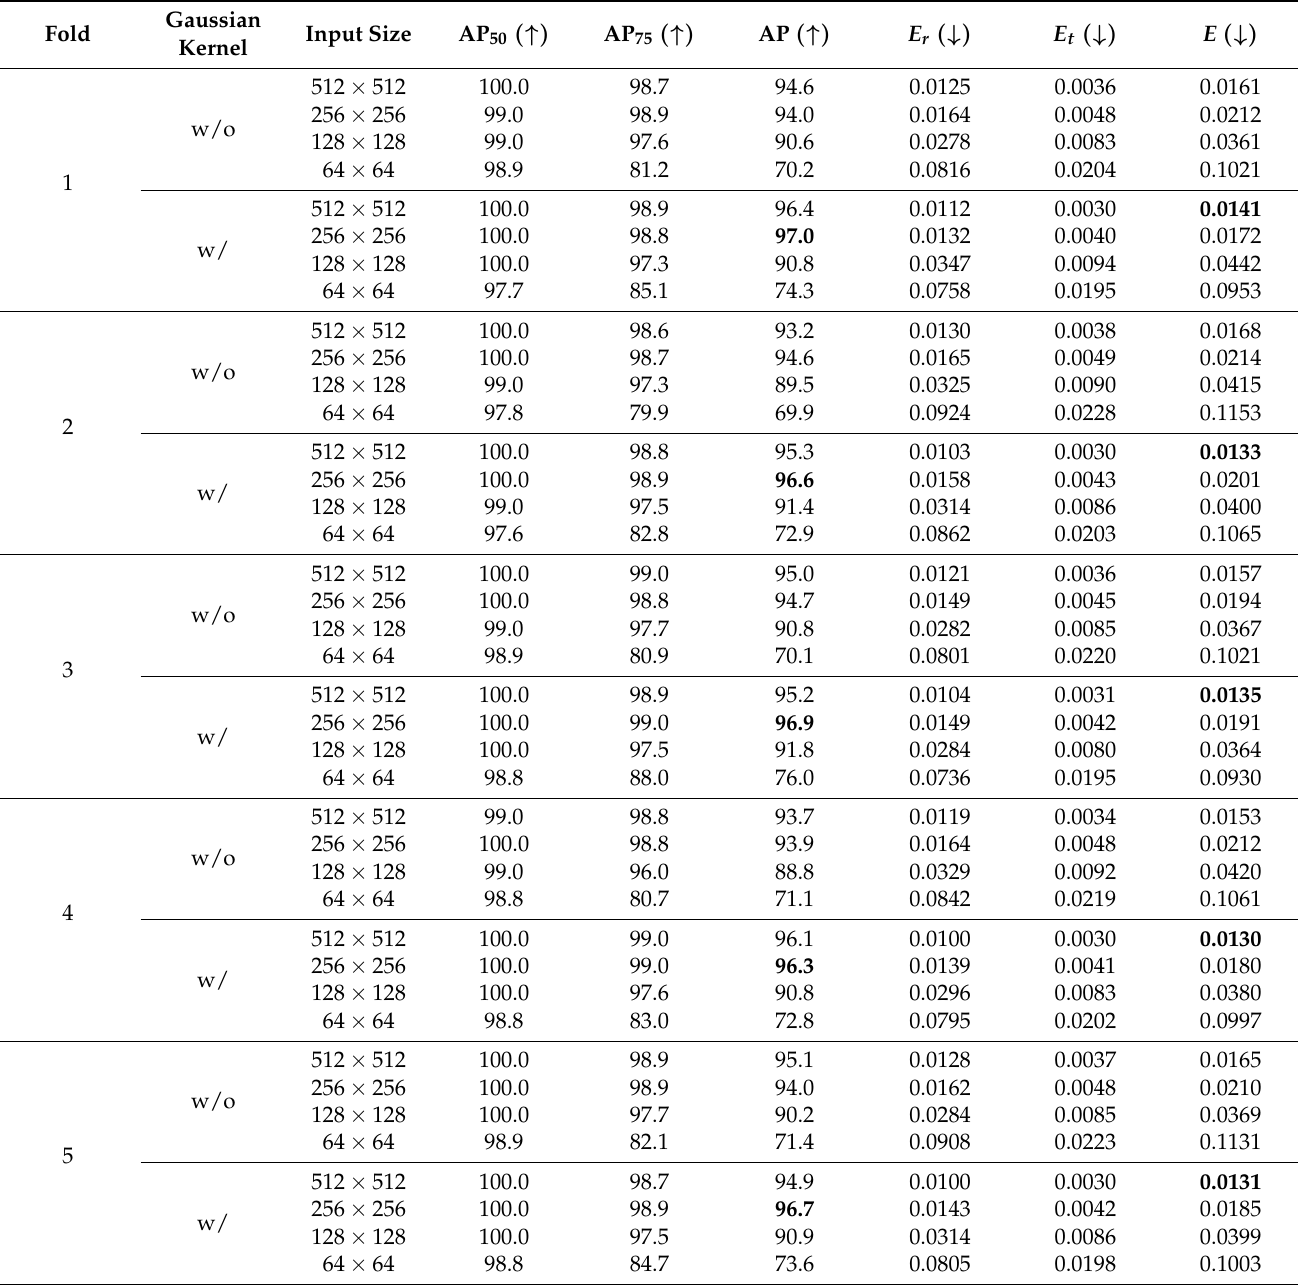
Table 1. Quantitative results of space target landmark regression and pose estimation using the proposed 1D landmark